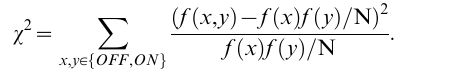
right indicates the daughter cell, and the downward arrow indicates the divided mother cell. Yellow ( HMR -left PEV) and blue (TEL-VR PEV) cells indicate a fluorescence intensity . 0.3,